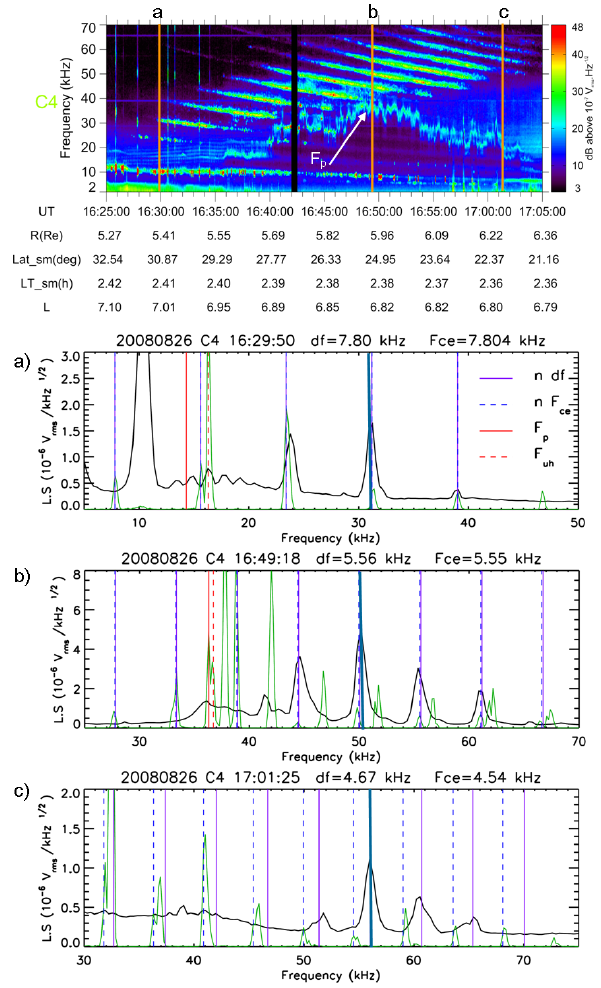
Figure 5. Spectral characteristics of the electric field measured by C4 during the 26 August 2008 event. Top: time–frequency spectro- gram from 16:25 to 17:05UT, orange lines indicate selected times of the spectra shown below. Bottom: individual spectra for the three selected times ( a 16:29:50UT, b 16:49:18UT, c 17:01:25UT); df and F c e series plotted as in Fig. 1; F p and F uh positions are pointed by red segments; steel blue segments mark the frequency F m of the main peak of the NTC series. Sounding spectra, recorded 8s after indicated times, are plotted in green, with electric field magnitudes divided by a factor 100.